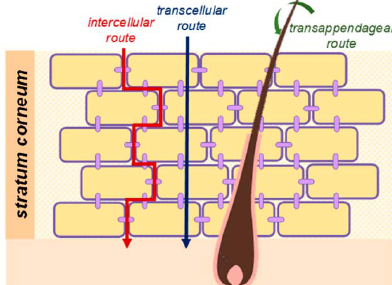
Figure 1. Schematic view of skin permeation pathways: intercellular, transcellular, and transap- pendageal [4]. Reprinted with permission from ref. [4]. Copyright 2021 MDPI. The evolution of strategies to promote percutaneous penetration of molecules and macromolecules is schematized in Figure 2 [5]. Current approaches encompass: (i) physi-